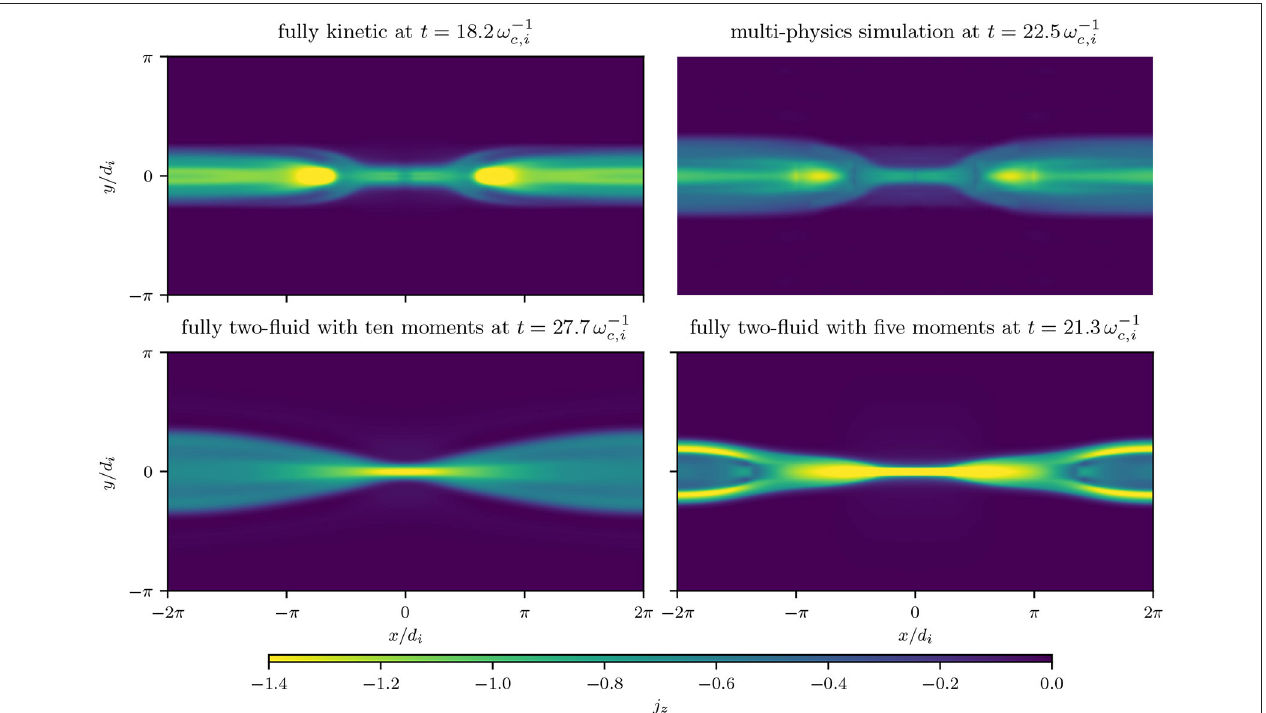
FIGURE 4 | j z at highest reconnection rate for the coupled run and some uncoupled comparison runs with a single solver.